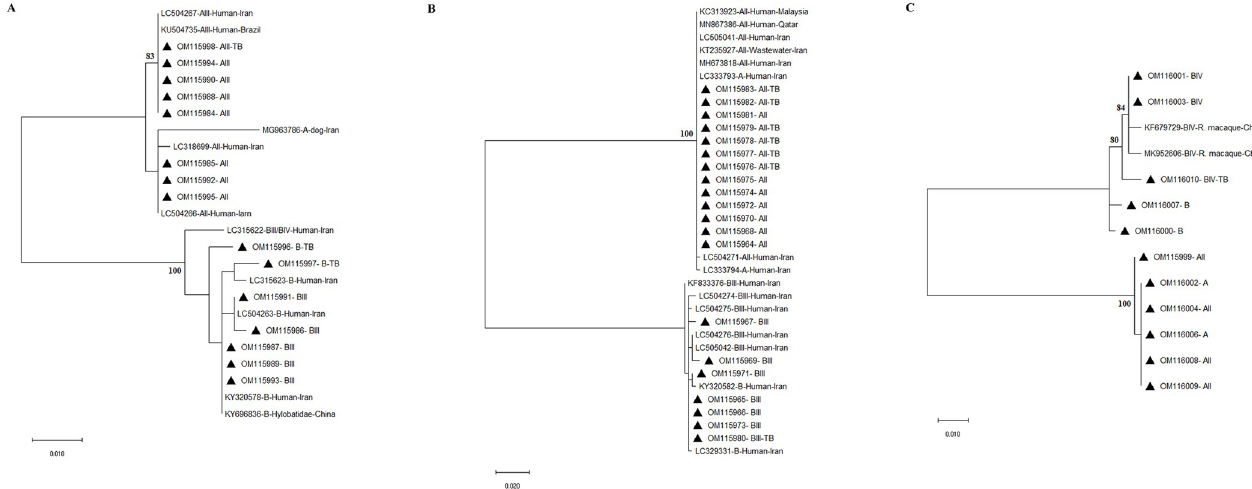
Fig 1. Phylogenetic trees of A) bg , B) tpi , and C) gdh genes of G . duodenalis obtained from this study together with reference sequences retrieved from GenBank. The trees were constructed based on the Maximum likelihood (ML) method and the Tamura 3-parameter model in MEGAX. Bootstrap values lower than 75 were omitted. Our sequences were indicated with black-filled triangles ( ▲